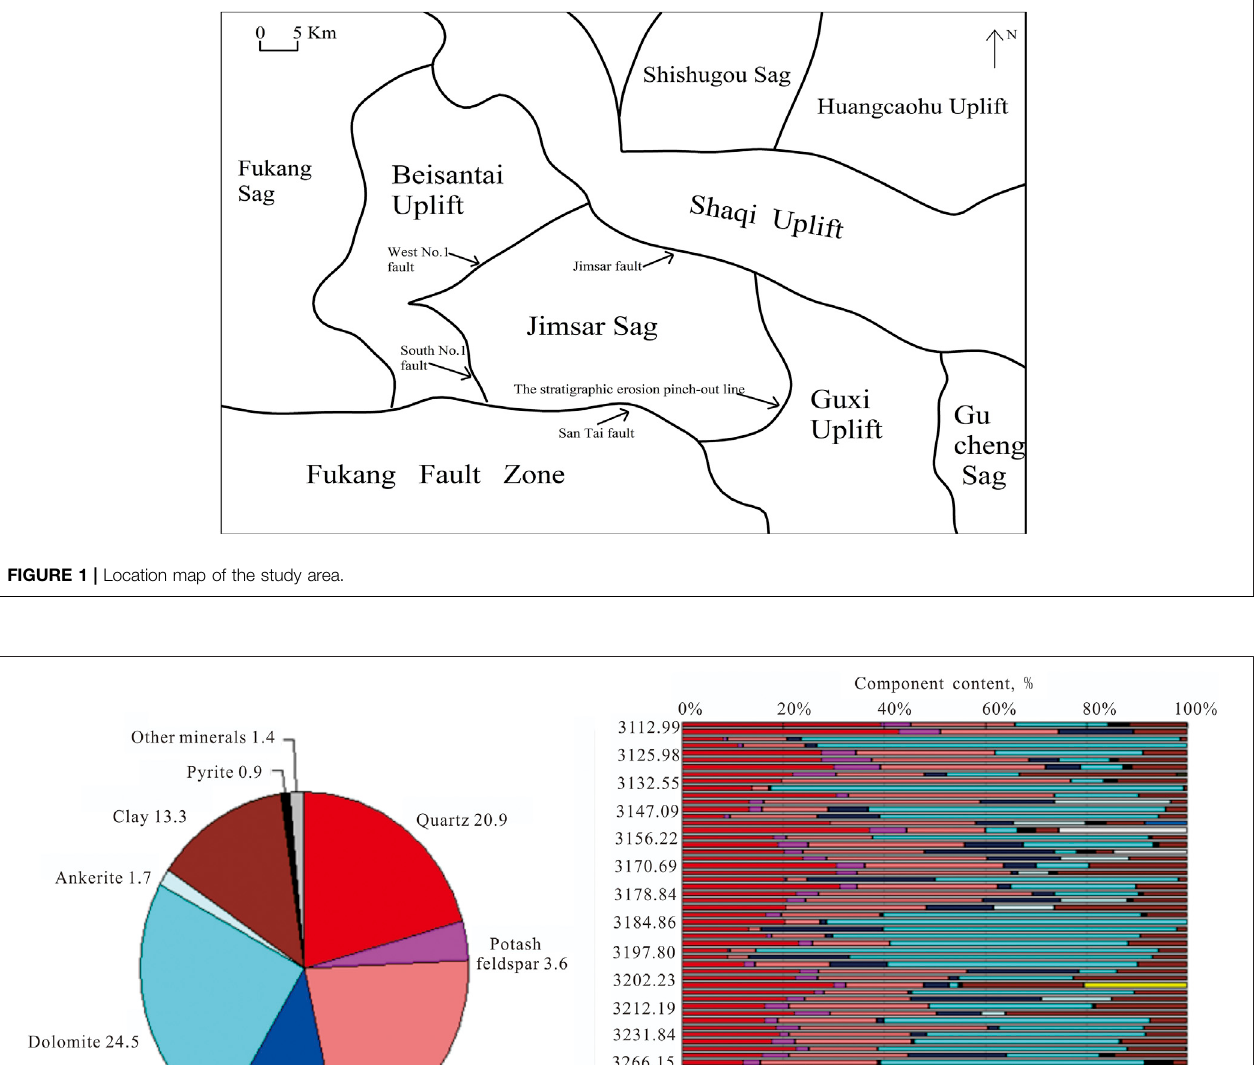
Frontiers in Earth Science |